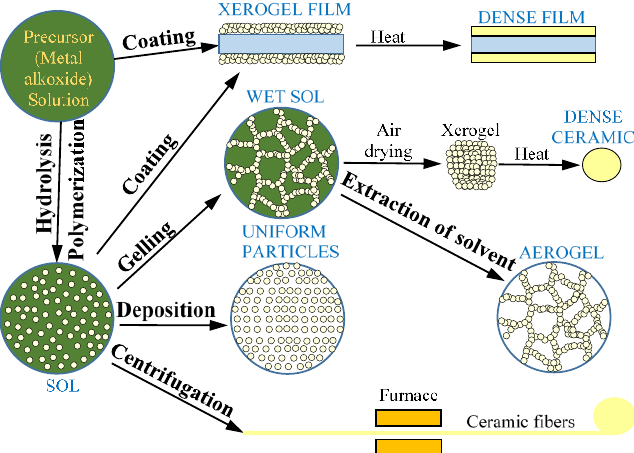
Figure 27. Sol–gel process